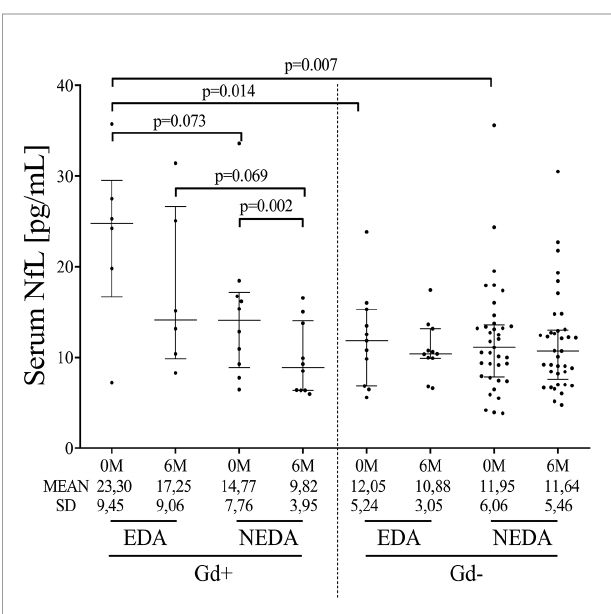
FIGURE 4 | Ocrelizumab treatment induces changes in sNfL levels. sNfL levels (pg/mL) measured before (0M) and at 6 months (6M) of ocrelizumab treatment and classi fi ed based on their in fl ammatory status (presence [Gd+] or absence [Gd-] of gadolinium enhancing lesions at baseline) and response (NEDA or EDA) to treatment at one year of follow-up. N was 6, 10, 12 and 41 in Gd+ EDA, Gd+ NEDA, Gd- EDA and Gd- NEDA, respectively. sNfL, serum neuro fi lament light-chains; SD, Standard